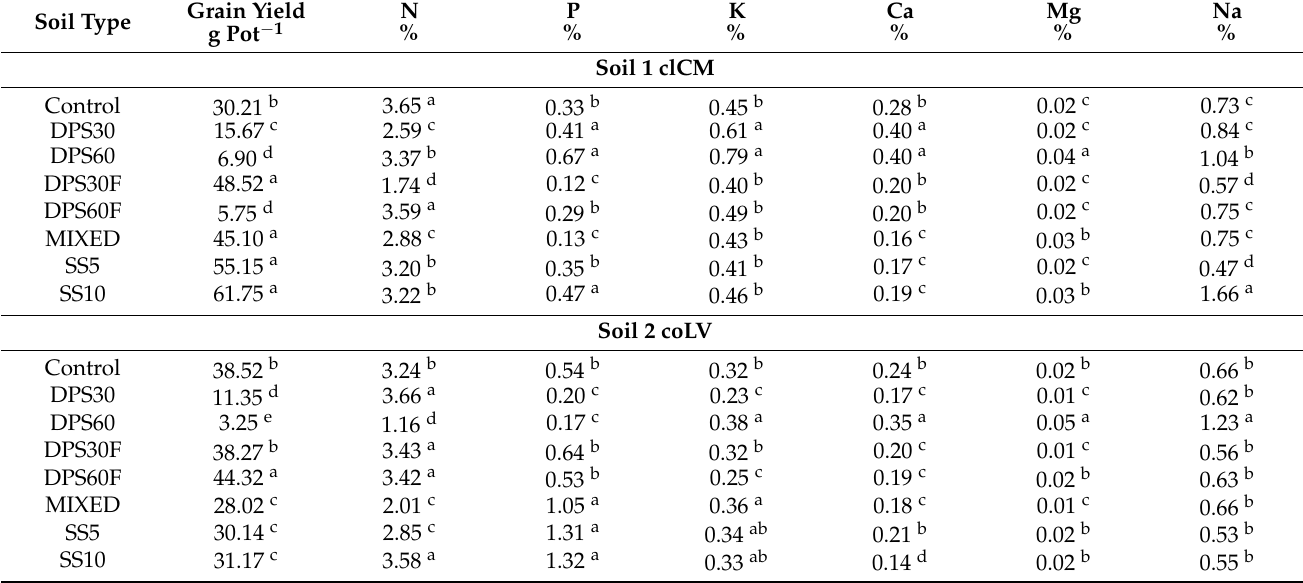
Table 6. Wheat grain yield and selected elemental composition as affected by biosolid application. Soil Type